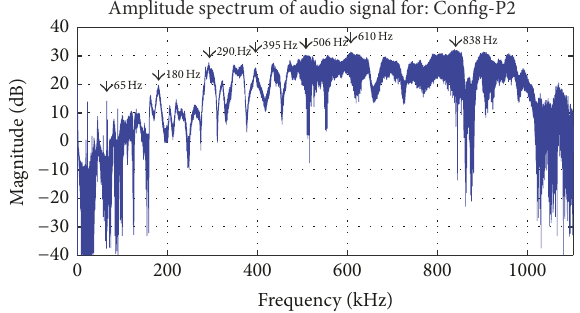
Figure 22: Spectral analysis showing modal frequencies excited for the LSRA at